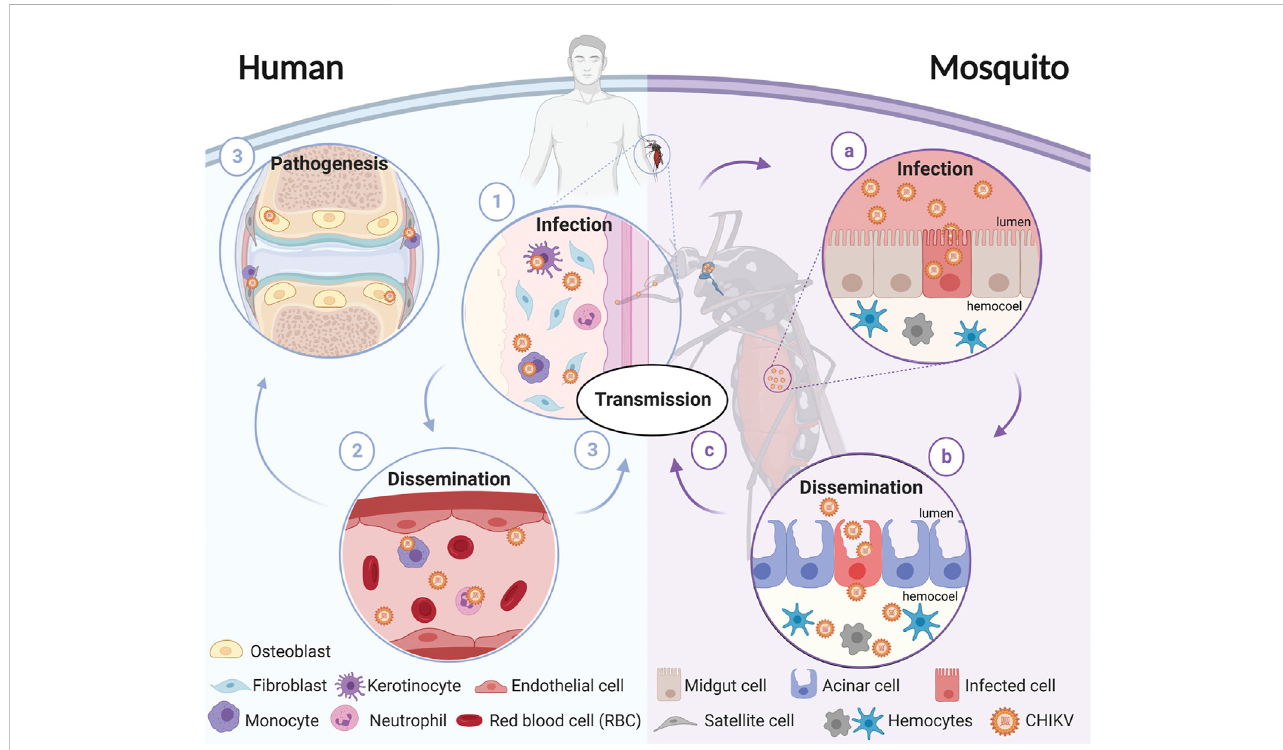
FIGURE 1 Schematic representation of CHIKV transmission cycle. CHIKV transmission starts when a female mosquito bites an infectious host. The virus enters through the bloodmeal and (a) infects the mosquito ’ s midgut, (b) enters the circulatory system where it disseminates to different tissues, and (c) eventually reachesthesalivaryglands.Thevirionspresentinthesalivaryglandsofthemosquitoaretransmittedtoasusceptiblevertebratehostwhenthemosquitotakes a blood meal. In humans, (1) virions enter and replicate in the fi broblasts and (2) disseminate until (3) reaching target tissues including the liver, joints, lymph nodes, muscles, and the brain. Diagram was created in